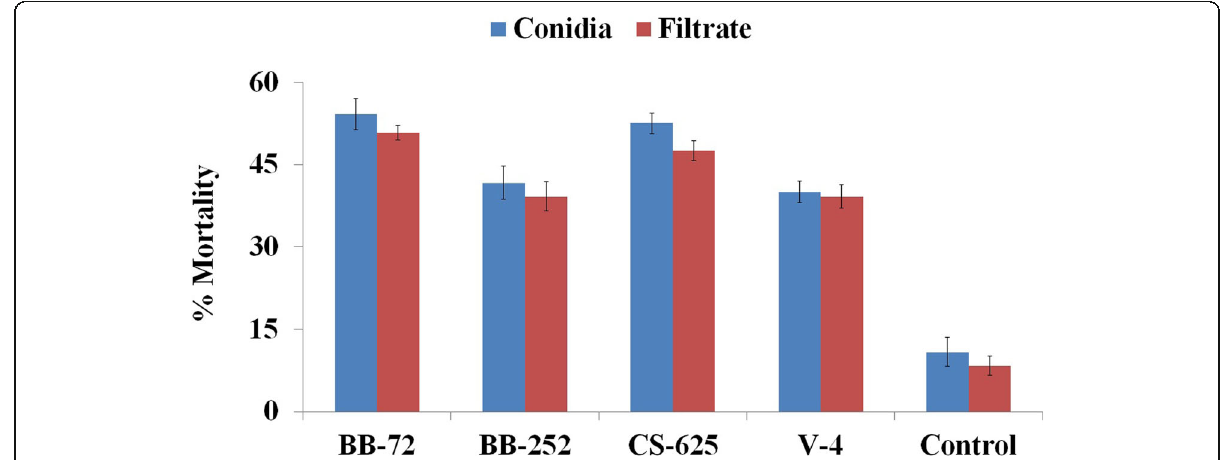
Fig. 3 Overall effects of fungal isolates on Myzus persicae